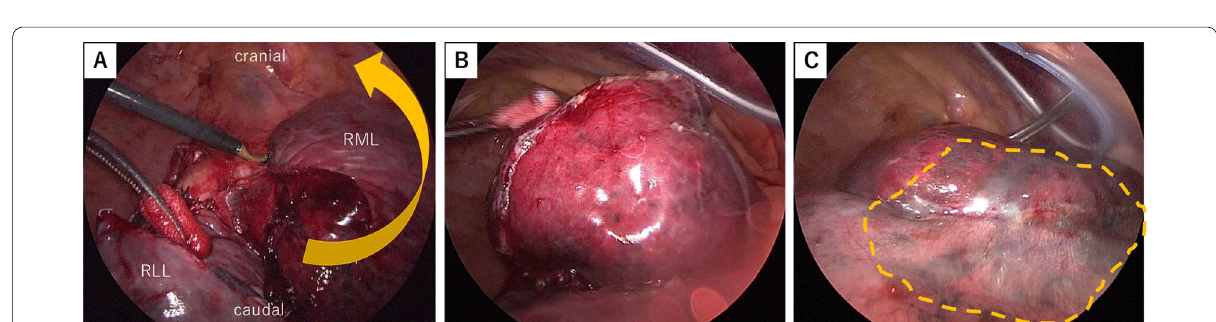
Fig. 2 A Intrathoracic findings after right upper lobectomy with partial middle resection and S6 segmentectomy. B The middle lobe rotated easily when the lung was inflated. C The absorptive sheet, 0.15 mm thick (Neoveil: NV-M-015G, Gunze Ltd, Kyoto, Japan), was cut to approximately 50 33 mm. Each piece was soaked in 1.0 mL of liquid fibrinogen (Bolheal; KM Biologics Co, Kumamoto, Japan) and placed over the contiguous × lobes in a bridging manner under lung inflation. Next, 1.0 mL of liquid thrombin was placed as drops onto the sheet, followed by fibrinogen and thrombin (1.0 mL of each), the latter of which were sprayed together to promote adherence. This fixation was performed in three locations for 5